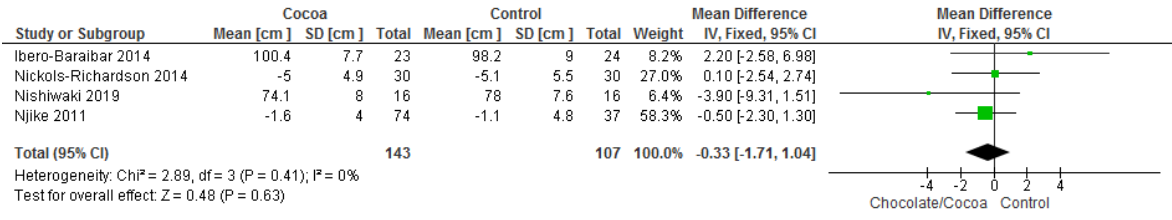
Figure 11. Forest plot of comparison: chocolate versus control, with the outcome - waist circumference (cm).